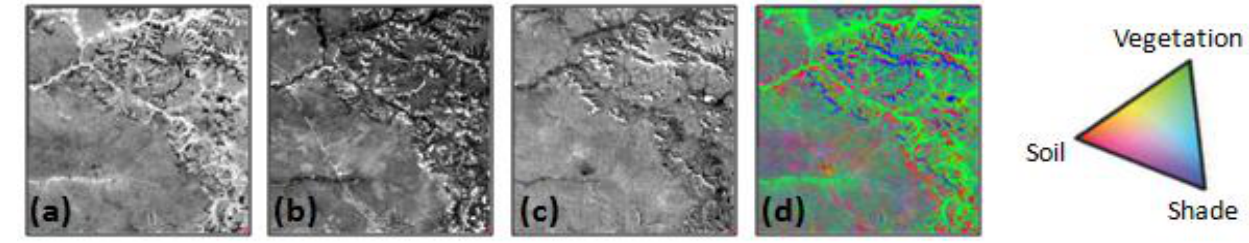
Figure 1. Images resulting from spectral mixing analysis at our research site. Images depict proportions of (a) vegetation, (b) soil and (c) shade, with brighter areas representing higher proportions. A color composite of these fraction images (d), shows the association: vegetation/green, soil/red and shade/blue, demonstrating the spatial distribution of proportions of primary landscape descriptors in Boa Vista (e.g., denser vegetation along streams and variations in soil proportions over the sandy plain, on the lower left corner of the area). The triangle on the right presents potential colors resulting from the combination of the three primary descriptors, with vertices representing pure pixels. Image brightness and contrast were modified to facilitate visualization. Original spatial resolution is 30 m and images represent an area of 13.5 by 15 km on the